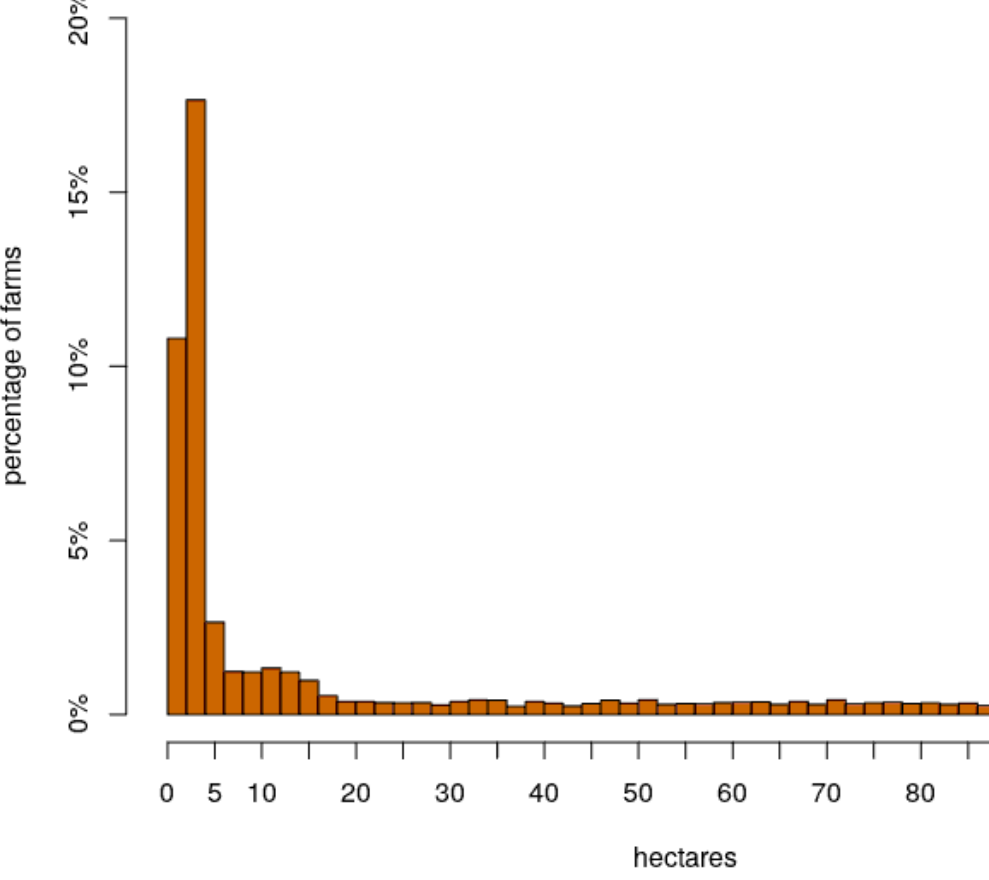
Figure 2. Frequency distribution of the cultivated area of roses per farm.